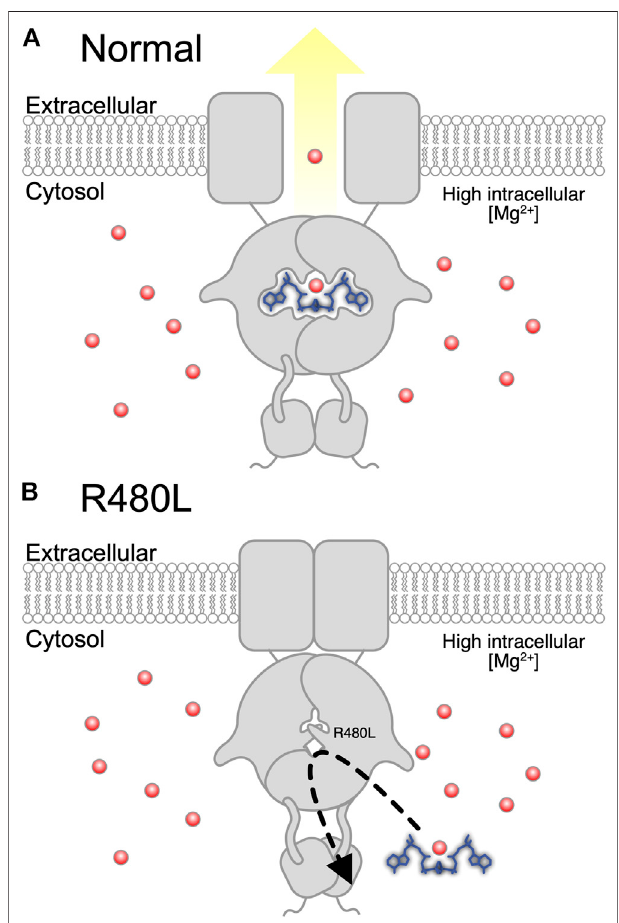
FIGURE 7 | Proposed pathogenesis of hypomagnesemia due to R480L of CNNM2 . (A) Normally, Mg 2+ is ef fl uxed after Mg 2+ -ATP binds to wild-type CNNM2 under magnesium depletion. (B) Mutation in CNNM2 yields a decreased binding force between CNNM2 and Mg 2+ -ATP and subsequent hypomagnesemia under magnesium